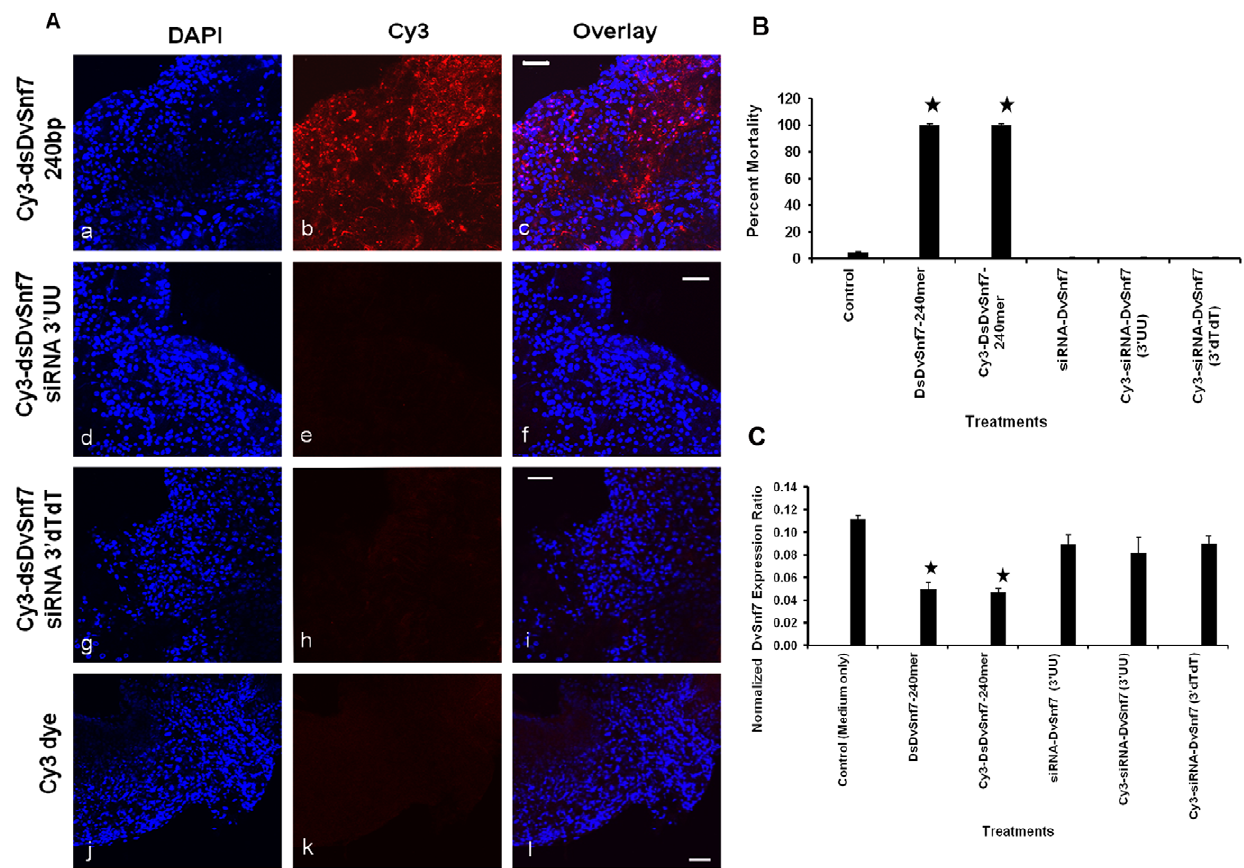
Figure 2. Uptake of dsRNA by Western Corn Rootworm (WCR, Diabroticavirgiferavirgifera ) by midgut cells. (A) Cy3-labeled 240 bp DvSnf7 dsRNA is taken up by WCR midgut cells (b–c), while DvSnf7 siRNAs are not (e–f, h–i). Nuclei DAPI staining was used to visualize midgut cells (a, d, g, j). Controls with Cy-3 dye alone do not show intracellular incorporation (k–l); Scale Bar: 50 m m.(B) Diet bioassays confirmed that labeled 240 bp dsRNA retains activity, while siRNAs are inactive. Percent mortality was determined 12 days after continuous exposure of WCR neonates to 100 ng/ mL of dsRNA/siRNA. (C) Real-time RT-PCR of midgut tissue cultures exposed to 1 m g/100 m L of insect medium of dsRNA/siRNA. Snf7 mRNA levels are reduced after exposure to DvSnf7 240 bp dsRNA, while no mRNA reduction is observed after tissue incubation with siRNAs or control medium. Stars represent values significantly different from controls (p=0.05; t-test).